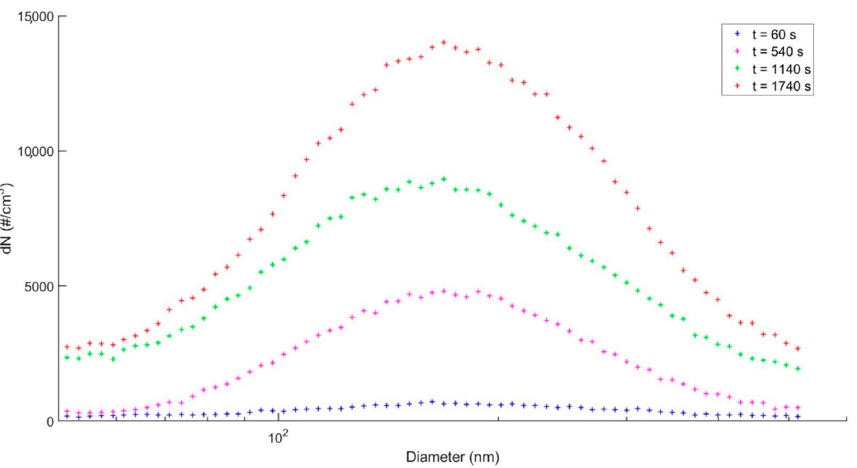
Figure A2. Particle size distribution at downstream filter α , for a velocity filtration of 6 cm/s, as different clogging times.